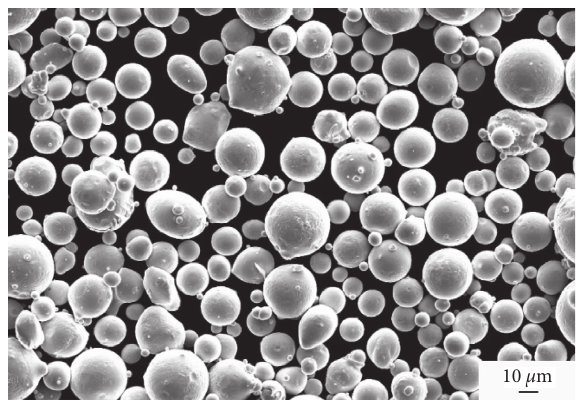
Figure 1: Microstructure of SLM 316L stainless steel powder. Table 1: Chemical components of 316L stainless powder (mass,